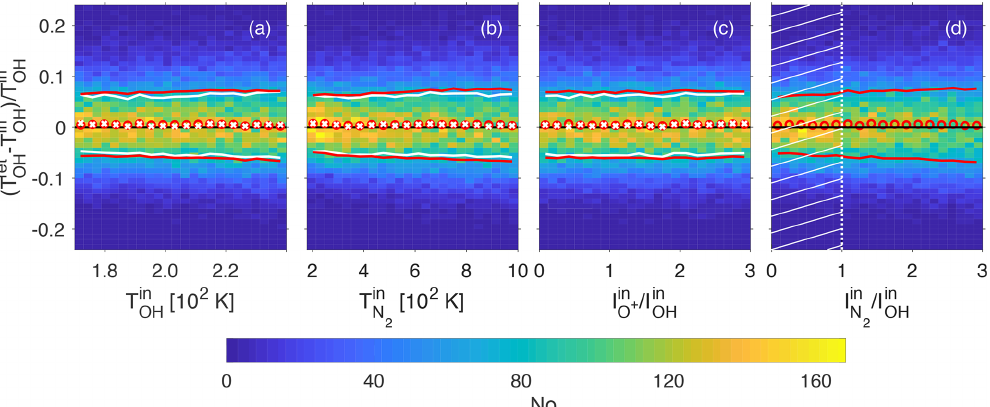
Figure 10. 2-D histograms of parameter retrieval tests showing the fractional error on OH temperature retrieval when the synthetic spectra are constructed using a different source for the energy levels of excited OH (Coxon and Foster, 1982) than used in the retrieval process (Krassovsky et al., 1962). Red circles indicate mean values and red lines are 1 standard deviation on either side of the mean. The white crosses and white solid lines in panels (a, b, c) represent mean values and 1 standard deviation on either side of the mean, respectively, but only including spectra for the N 2 intensity within the hatched area shown in panel (d)